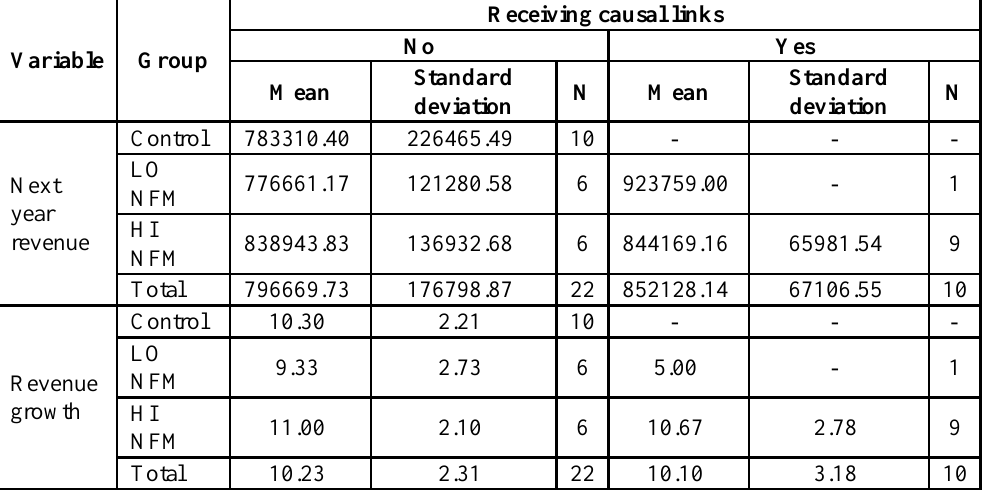
Table 7. Descriptive statistics (non-financial information with causal links for investors with low knowledge in million